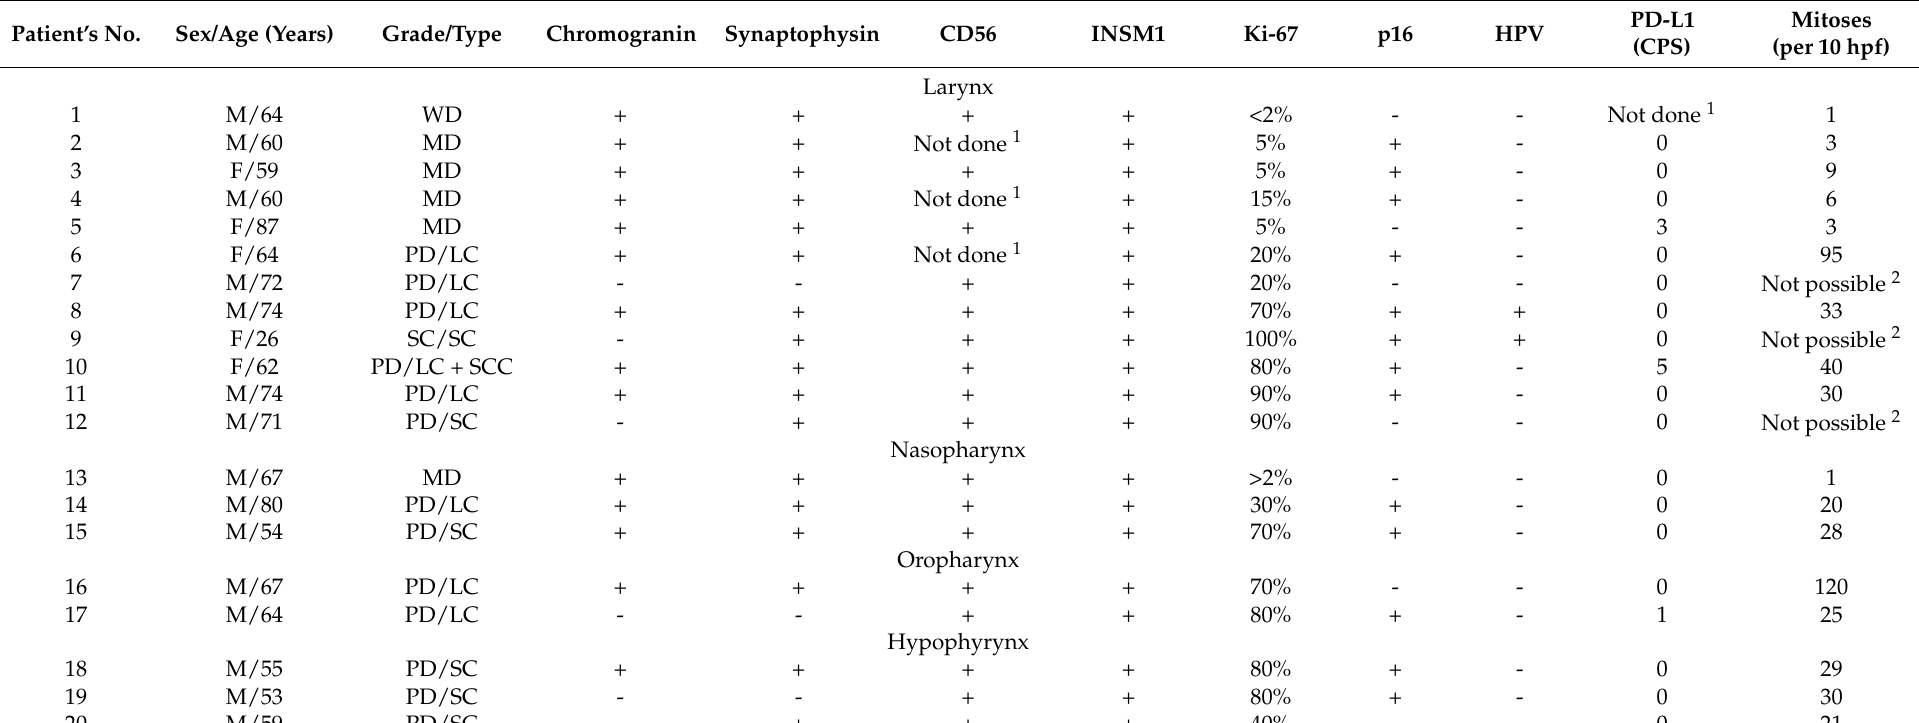
Table 3. Results of immunohistochemical and molecular